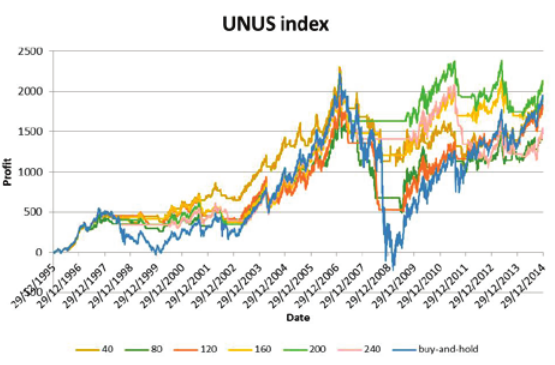
Figure 6. Profits of our strategy and “buy-and-hold” on EPGR index (without transaction